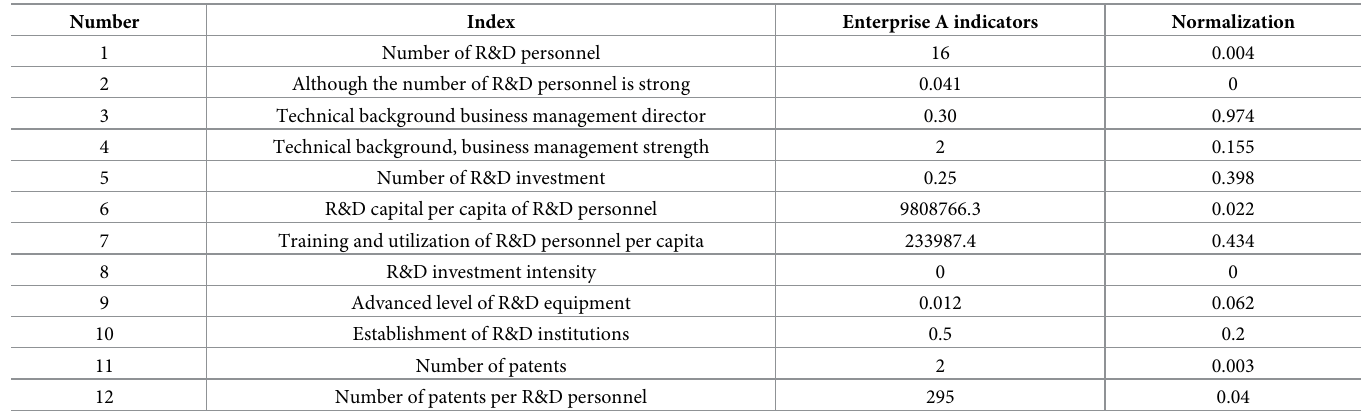
Table 2. Values and normalization of each indicator.